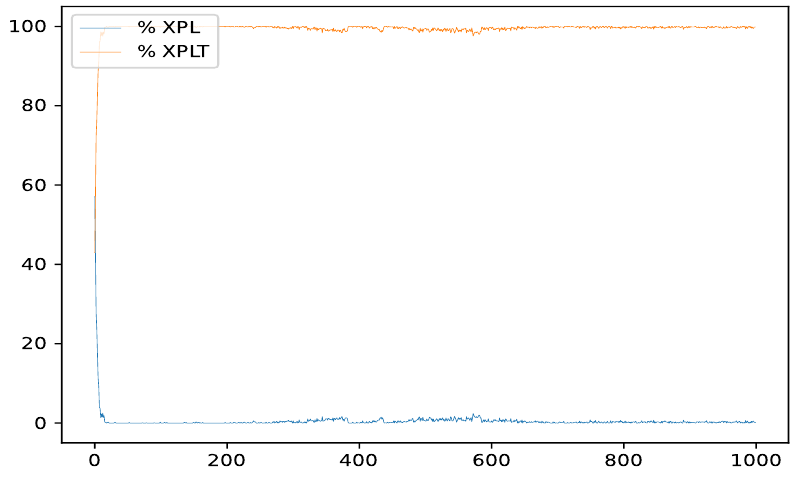
Figure 16. SCA-BCL-65 Dimensional Hussain.